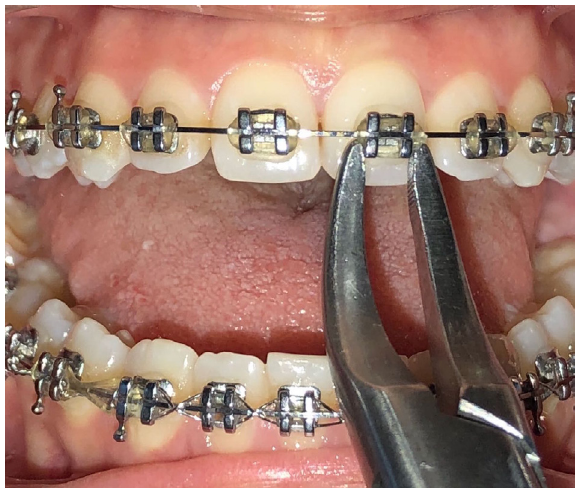
Figure 1- Intraoral photograph of conventional debonding